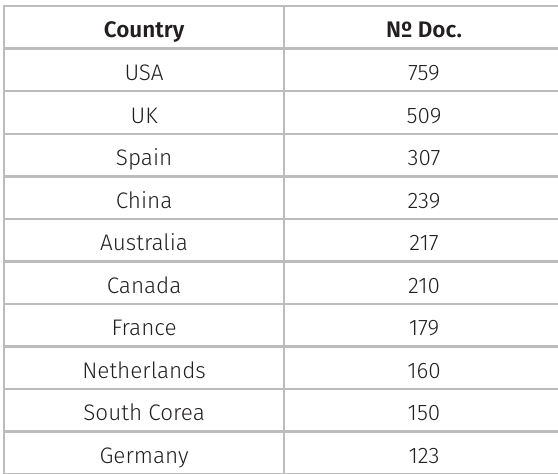
Table IV. Most productive countries in Corporate Social Responsibility research.